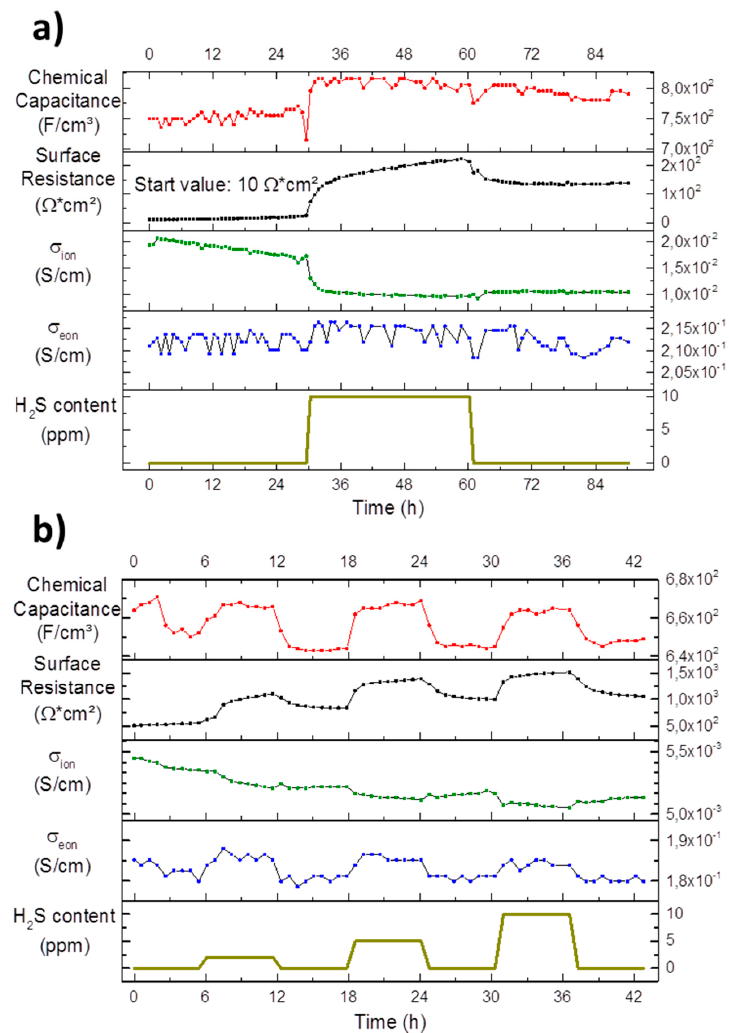
Figure 10. Chemical capacitance, surface resistance, ionic and electronic conductivity development of long-term measurements of Pt/GDC 10 interdigitated model-composite microelectrodes at 750 °C in an atmosphere of 2.5% vol H 2 in Ar with a hydrogen to water ratio of 1:1; the H 2 S content in the feed gas is plotted in the bottom diagrams. ( a ) Measurements on a pristine sample. The interdigitated current collectors had a width 15 µm, a spacing of 15 µm and a length of 980 µm with a total of 8 digits; ( b ) Measurements on an aged electrode after two cool downs to room temperature and a photolithography step to improve contacting. The interdigitated current collectors had a width 15 µm, a spacing of 5 µm and a length of 980 µm with a total of 12 digits.